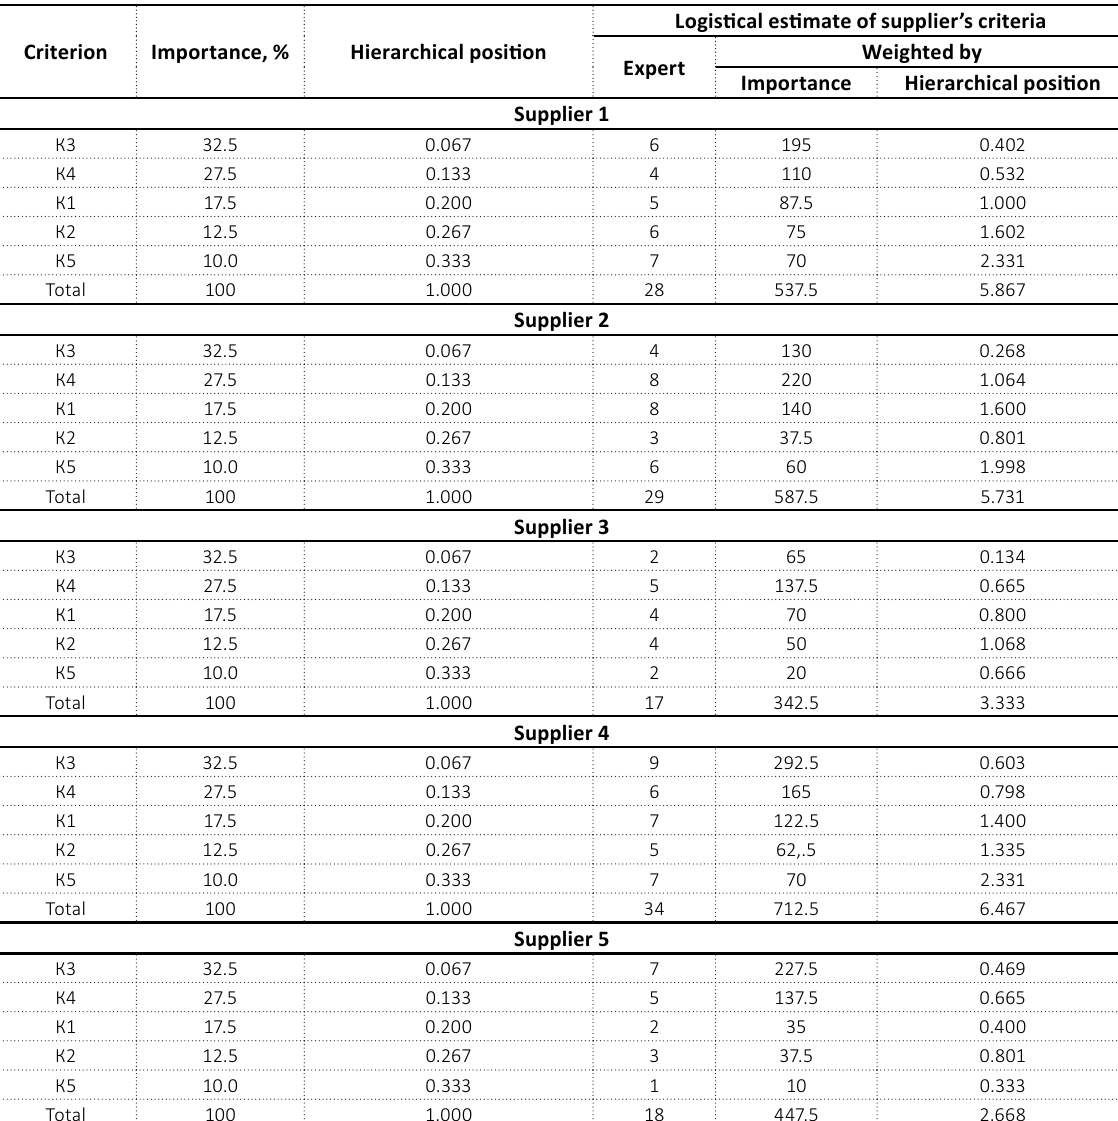
Source: Developed by the